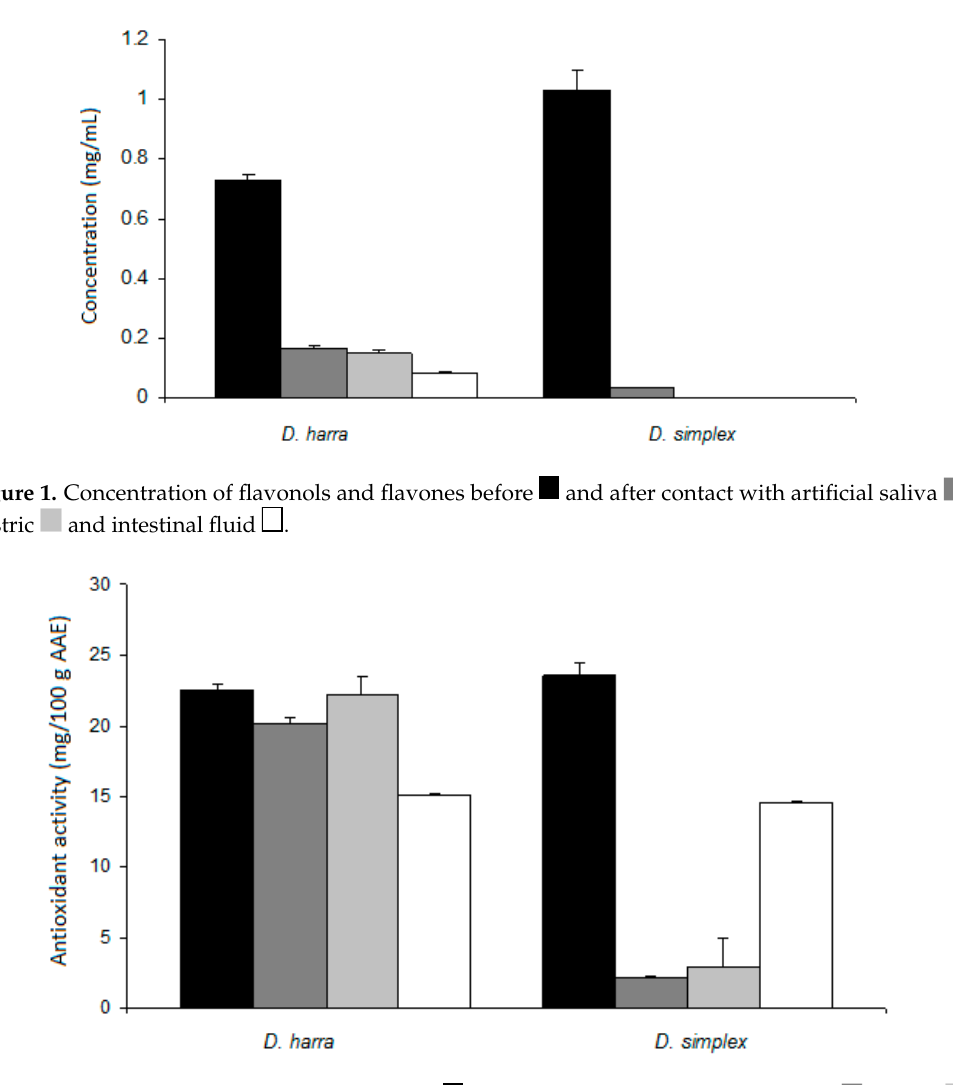
Figure 2. Antioxidant activity of extracts before and after contact with artificial saliva , gastric and intestinal fluid .